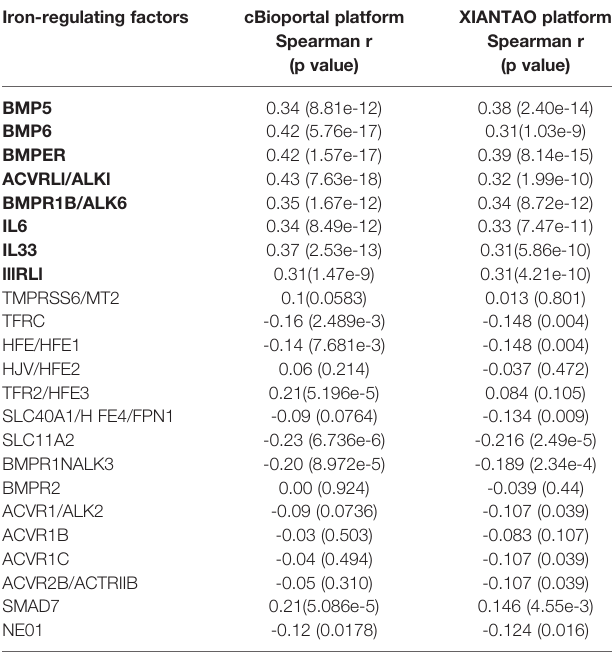
TABLE 1 | Correlations of HAMP with iron regulation-related genes. Iron-regulating